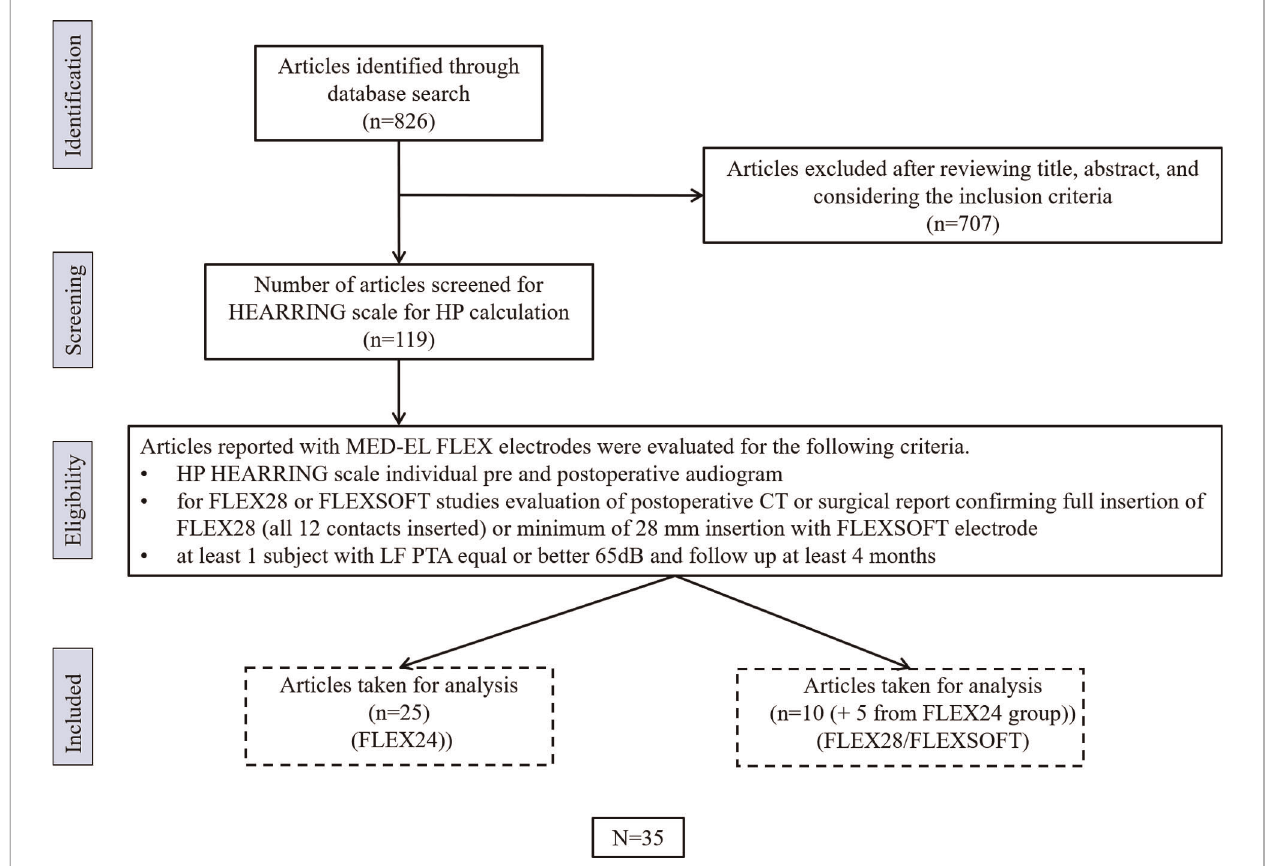
FIGURE 3 | PRISMA fl ow chart detailing the selection of literature for inclusion in the